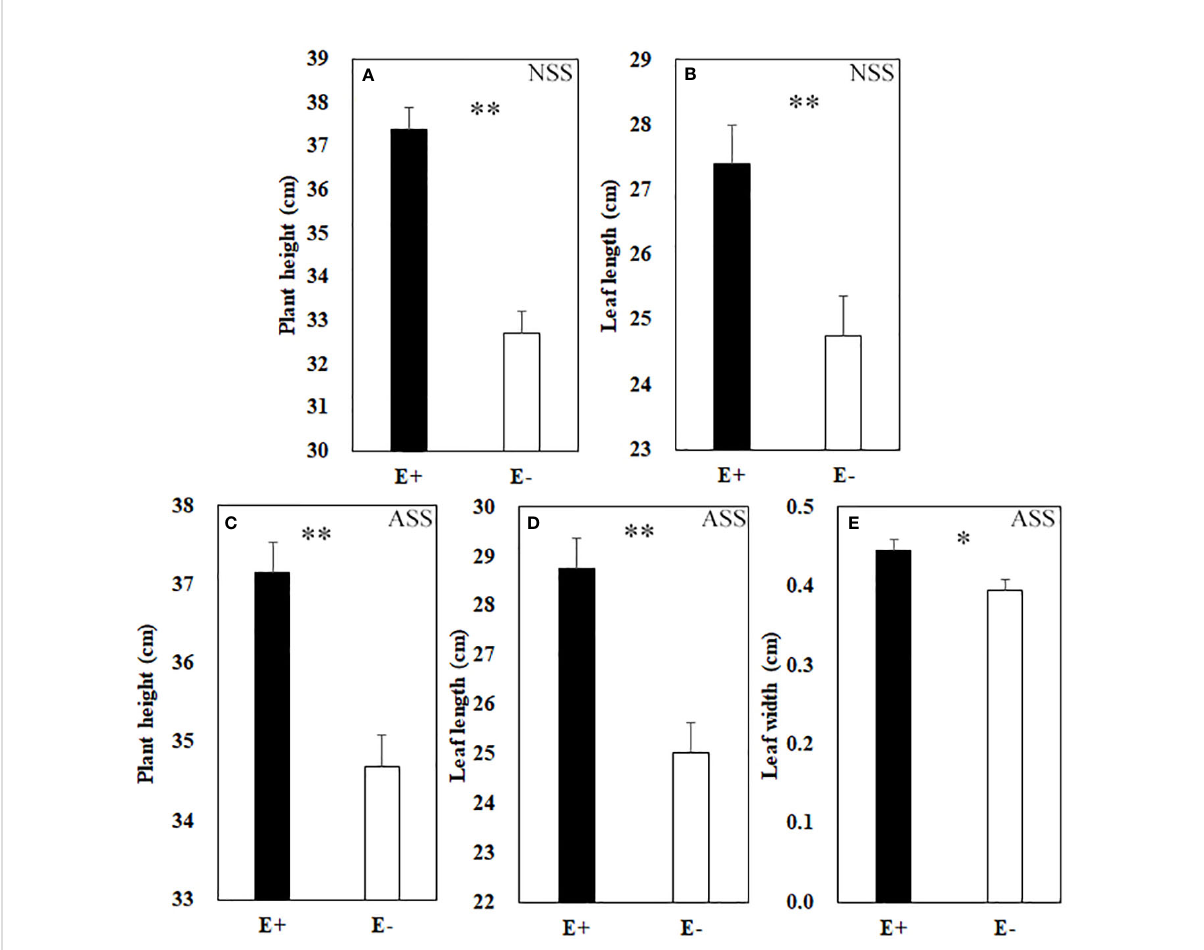
FIGURE 1 Plant height (A) and leaf length (B) under neutral salt stress (NSS) as well as plant height (C) , leaf length (D) and leaf width (E) under alkaline salt stress (ASS) of endophyte infected (E+) and uninfected (E − ) L. chinensis . Values are mean ± standard error. * and ** indicate signi fi cant difference at p < 0.05 and p < 0.01,